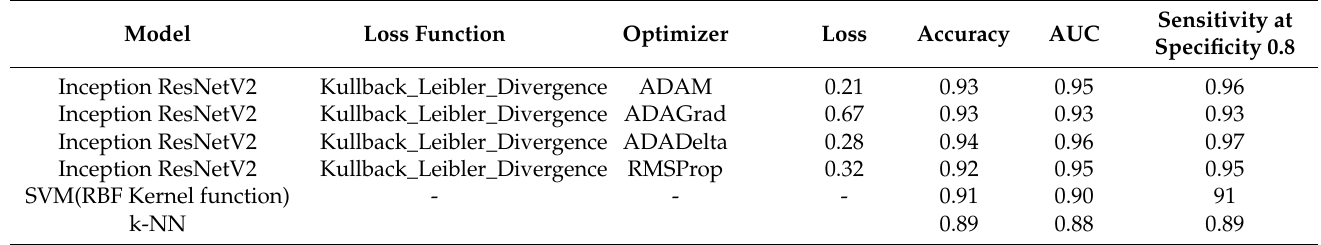
Table 4. Validation result of various models with a learning rate of 0.0001 and a batch size of 32 with InceptionResNetV2 Model and Kullback_Leibler_ Divergence loss function.